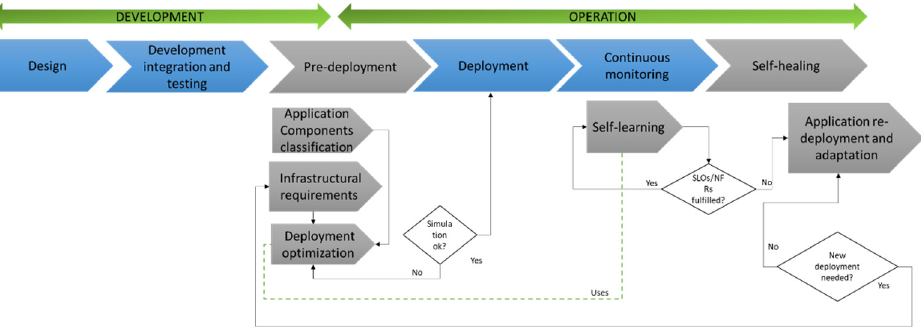
Figure 2 . CloudOps workflow for the operationalization in the Cloud Continuum